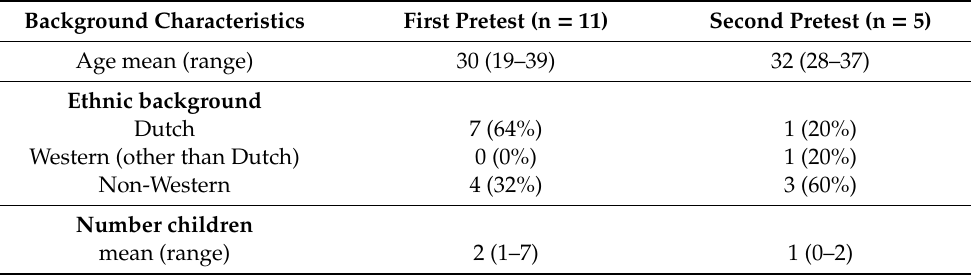
Table 5. Background characteristics stage 2 (n =